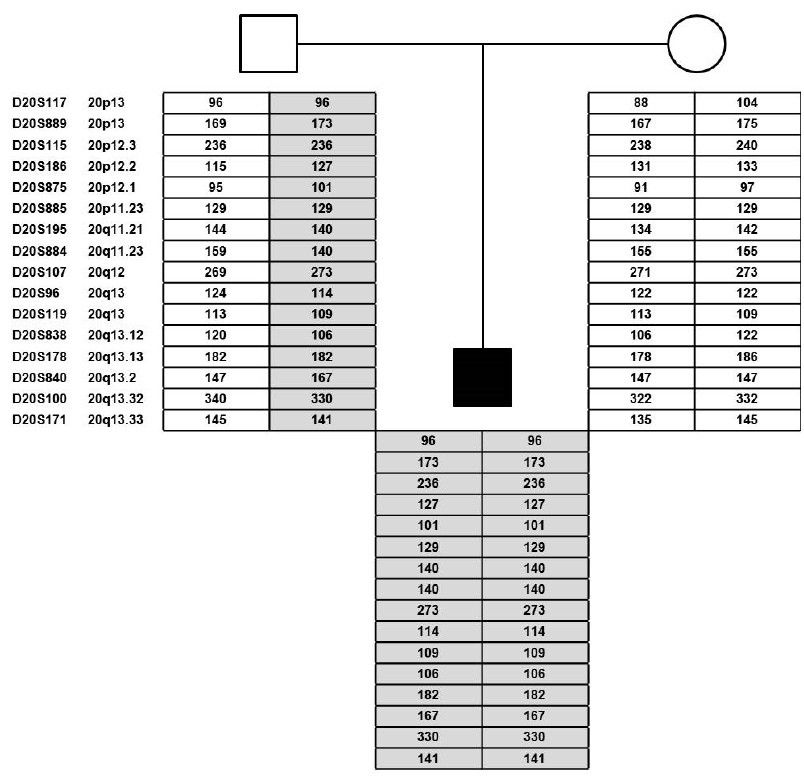
Figure 3. Polymorphic microsatellite marker analysis. Pedigree of the proband and his parents showing the results of the 16 polymorphic microsatellite markers distributed throughout the entire chromosome 20 (6 markers for chromosome 20p and 10 markers for chromosome 20q). This data confirms that the patient harbors isodisomy of the entire chromosome 20 originated from his father. Grey areas indicate the region of UPD and its parental origin.